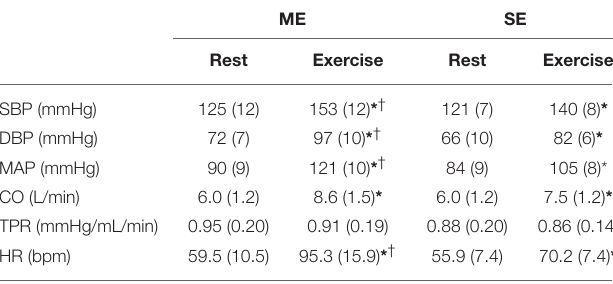
TABLE 1 | Hemodynamic responses to exercise.